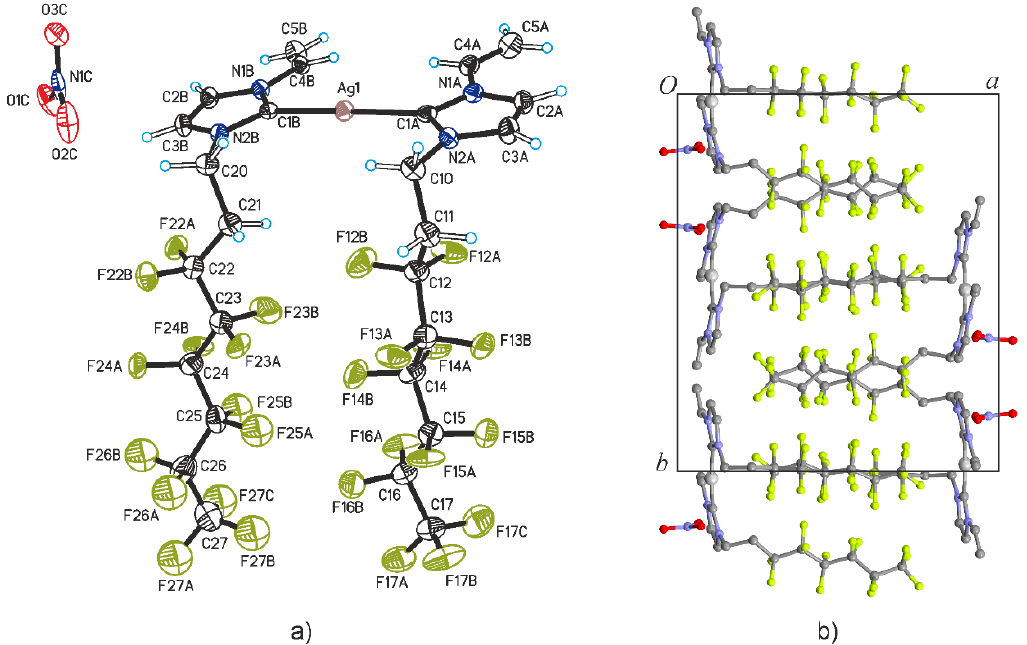
Figure 1. ( a ) Molecular structure of Ag(FNHC) 2 NO 3 with non-H atoms displayed as thermal ellipsoids drawn at the 30% probability level and H atoms drawn as spheres of random size (minor disorder omitted for clarity). ( b ) Packing arrangement with a central parallel/antiparallel stacked fluoroalkyl ponytails (minor disorder and H atoms omitted for clarity).